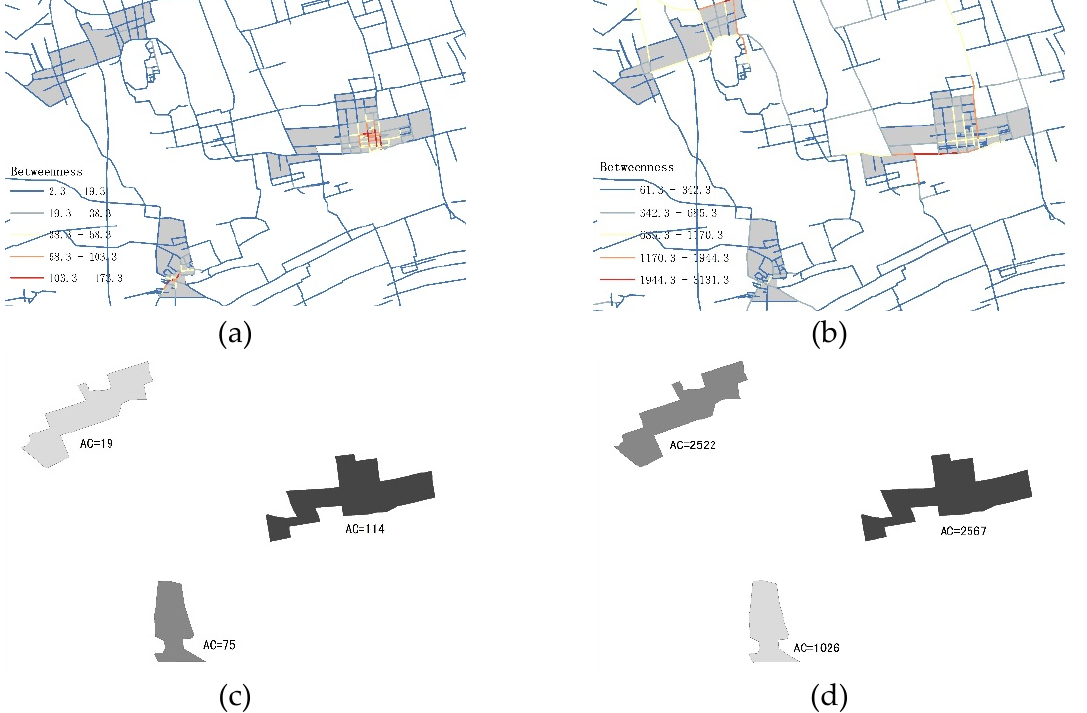
Figure 6. Examples of accessibility calculation for road network. ( a ) Betweenness value within radius 800 m. ( b ) Betweenness value within radius 5000 m. ( c ) Mean betweenness value weighted by length within radius 800 m. ( d ) Mean betweenness value weighted by length within radius 5000 m.